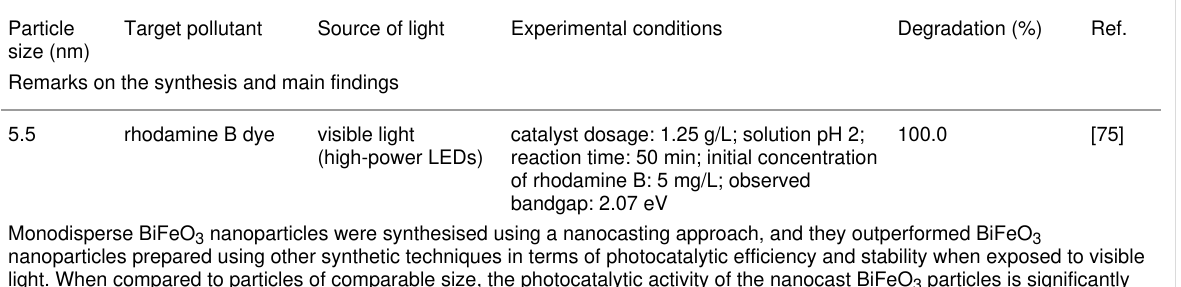
Table 2: Treatment of water containing antibiotics and dyes by bismuth ferrite nanoparticles (BiFeO 3 ). Particle size